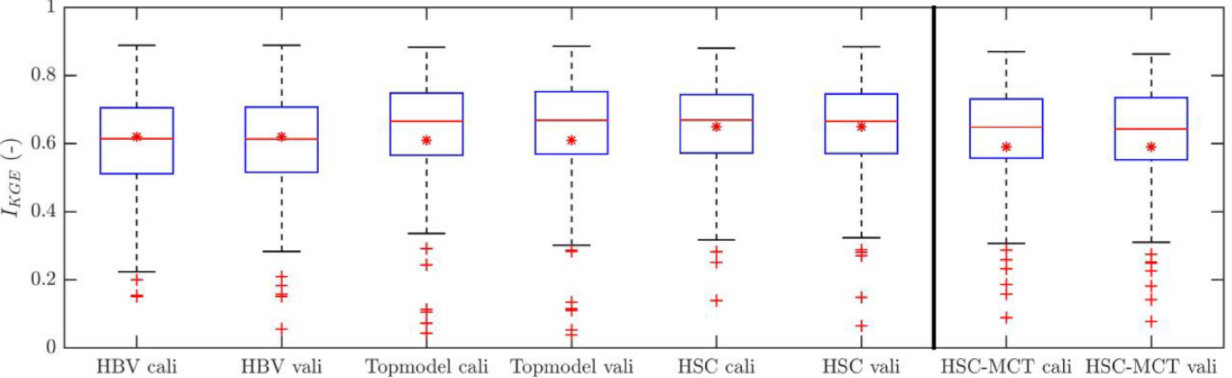
Figure 13. The comparison between the HBV, TOPMODEL, HSC, and HSC-MCT models.